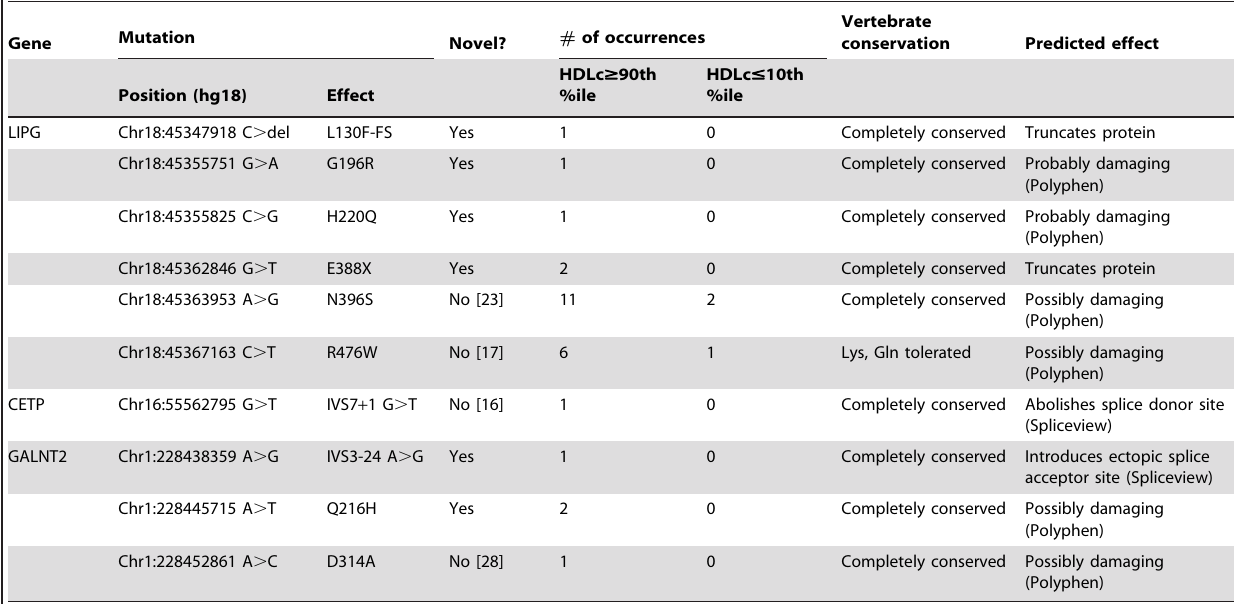
Table 3. LIPG , CETP , and GALNT2 mutations.